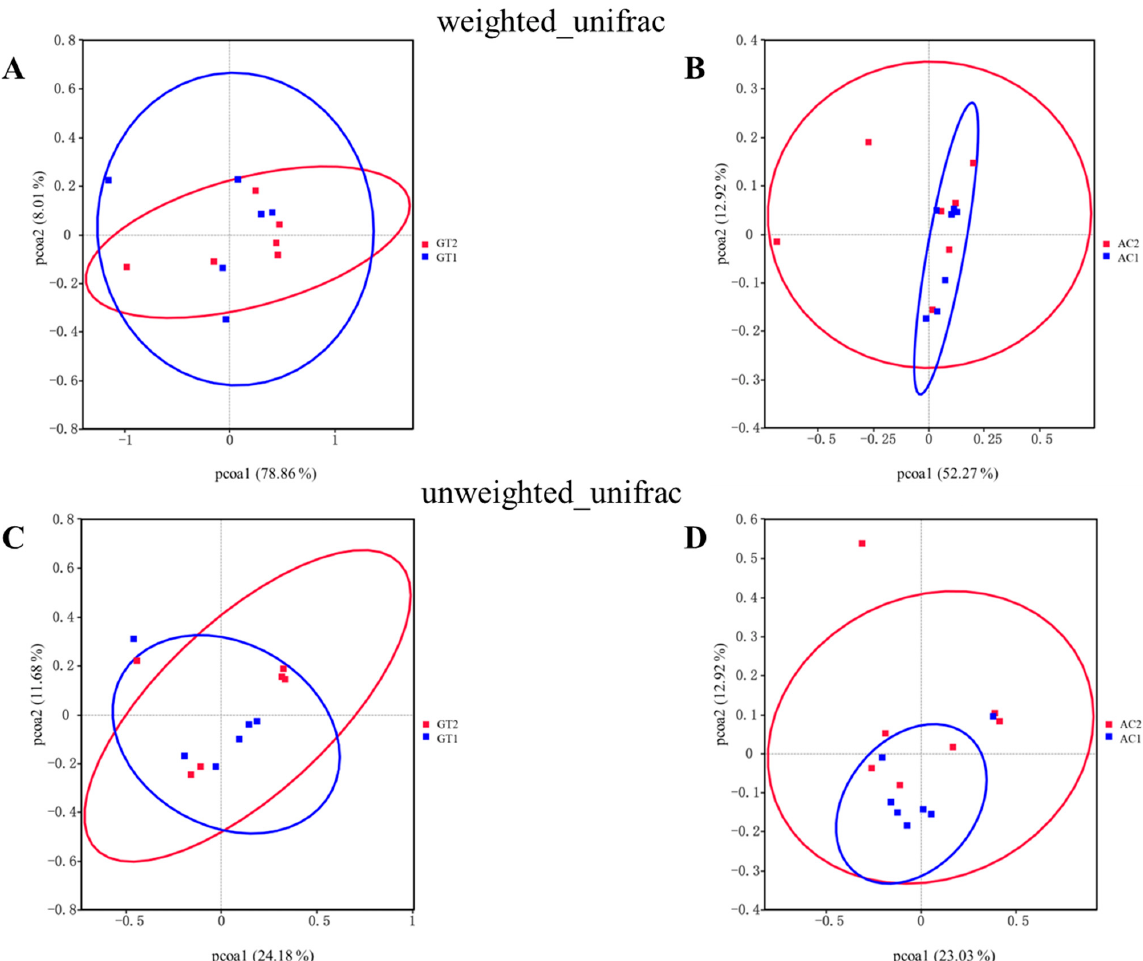
Figure 3. The β -diversity index analysis of GT and AC groups. The principal coordinate analysis (PCoA) of weighted_unifrac ( A ) and unweighted_unifrac ( B ) of GT groups and AC groups. GT1, before gradual transition, n = 6; GT2, after gradual transition, n = 6; AC1, before abrupt change, n = 7; AC2, after abrupt change, n = 7.